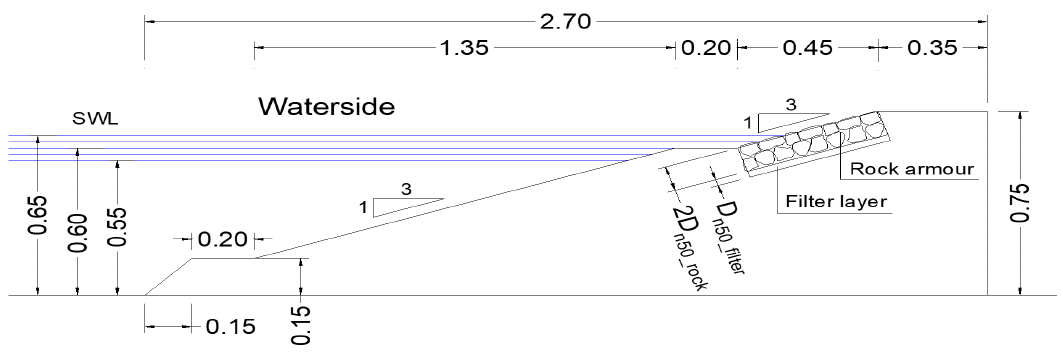
Figure 9. Test configuration (unit: m) of the R1N tests, with a rock-armoured upper slope, a smooth berm and a smooth lower slope with wider test conditions (including water levels and wave conditions) than R1. D n 50_ rock = 5 cm and D n 50_ filter = 2.5 cm.